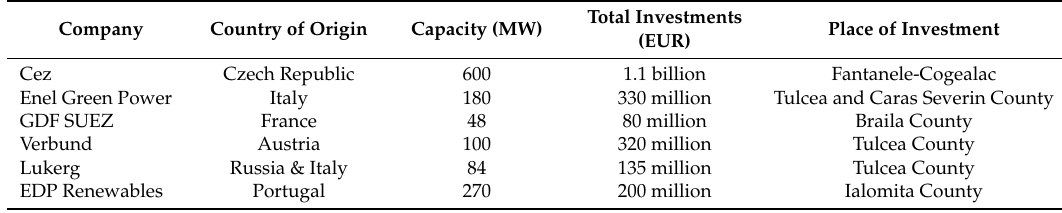
Table 2. Major investments in Romanian wind energy production.